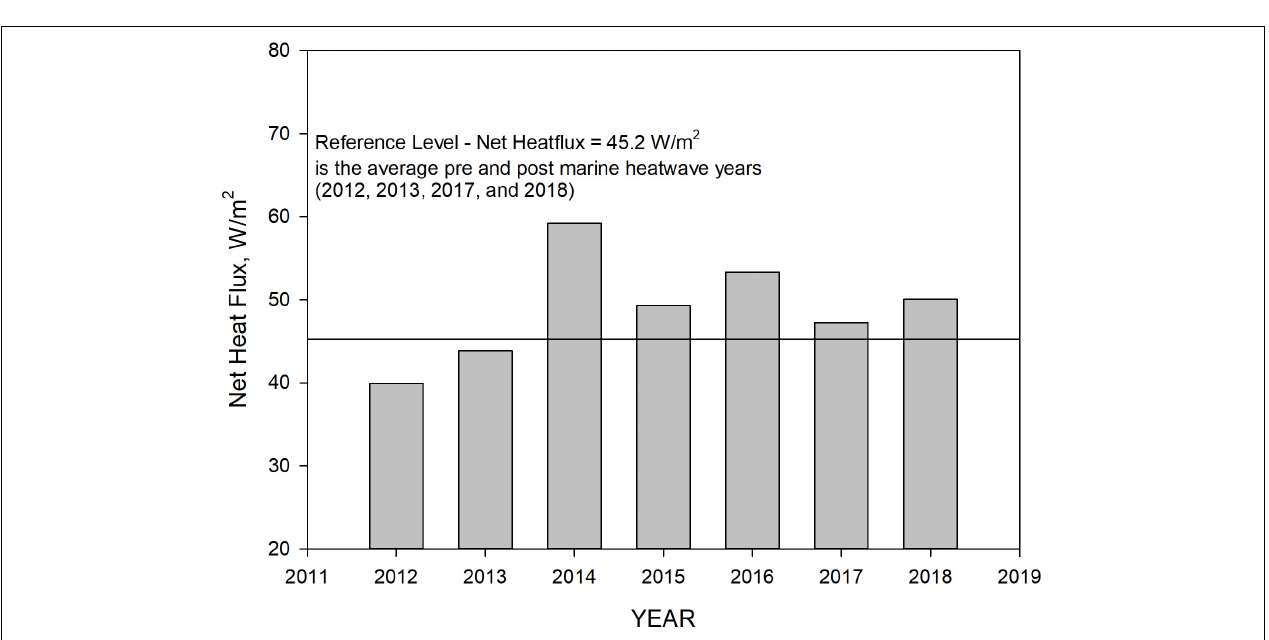
FIGURE 4 | Temperature difference contour plot along the Salish Sea Model boundary at the continental shelf edge to highlight the incoming marine heatwave through the ocean boundary. Distance is measured along the ocean boundary from the southernmost boundary node near Waldport, Oregon, to the northern most at Calvert Island in British Columbia, Canada at the north of Vancouver Island. (A) Temperature difference along the ocean boundary in March 2014 prior to the marine heatwave impingement and (B) during peak marine heatwave impingement in March 2015. The difference is relative to climatological monthly average from 1999 to 2009 selected as the reference condition at the